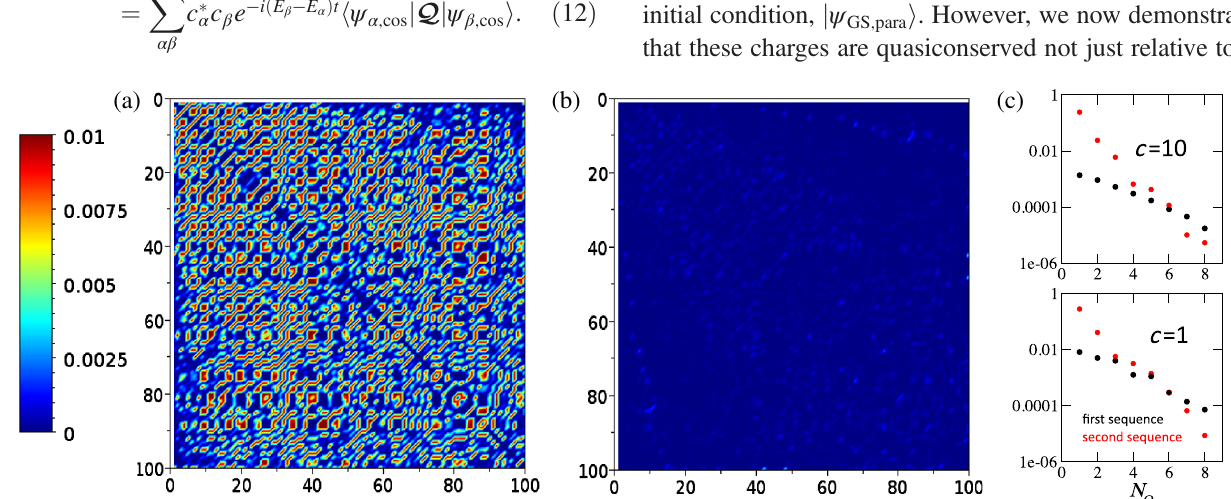
ˆ Q = h ˆ Q 2 2 i av ,comparingitto(b)theoffdiagonalm.e. ˆ Q m ¼ 1 ; … ; 8 , while in red is the sequence constructed from ˆ Q 2 m ,